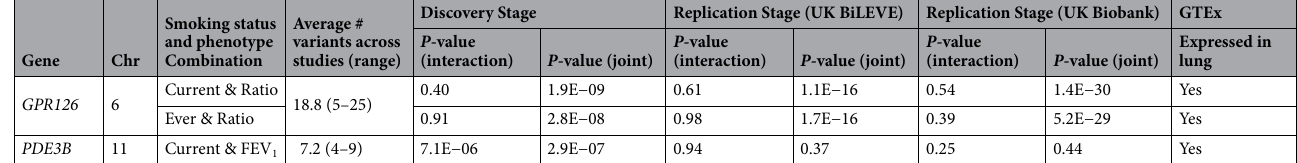
Table 2. Significant genes in the meta-analyses (significant threshold =